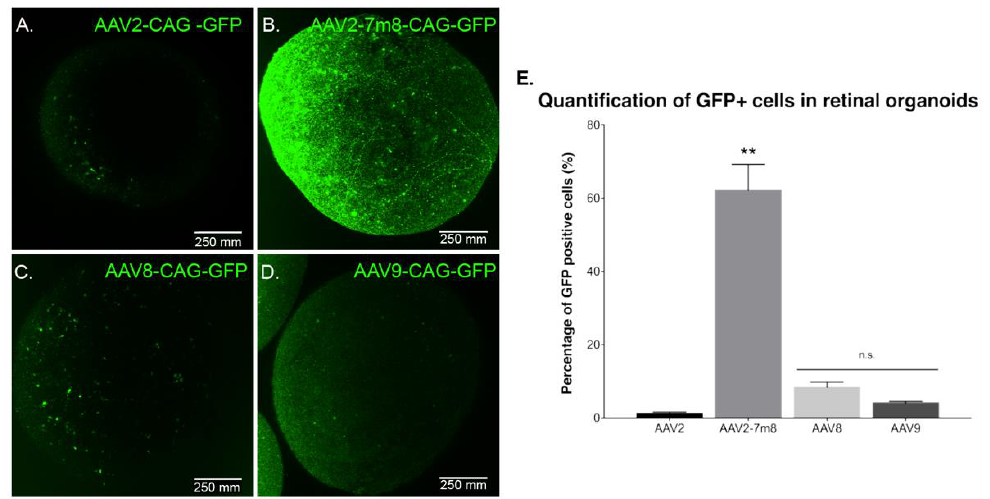
Figure 3. GFP expression as a function of the serotype. Live confocal imaging of representative retinal organoids showing GFP Expression driven by the CAG promoter for the four different tested capsids. ( A ) AAV2-CAG-GFP. ( B ) AAV2-7m8-CAG-GFP. ( C ) AAV8-CAG-GFP and ( D ) AAV9-CAG-GFP. In